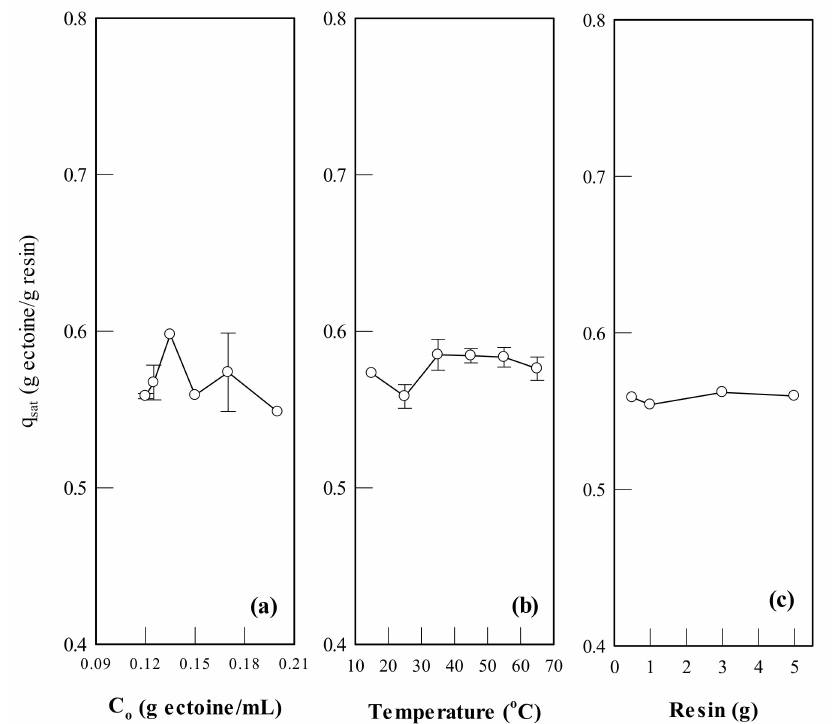
Figure 9. Effect of saturation adsorption capacity of ectoine using Dowex ® HCR-S on ( a ) initial ectoine concentration, ( b ) temperature, and ( c ) resin dosage (aqueous/resin = 4 mL/g, agitation = 100 rpm, reaction time = 8 h).